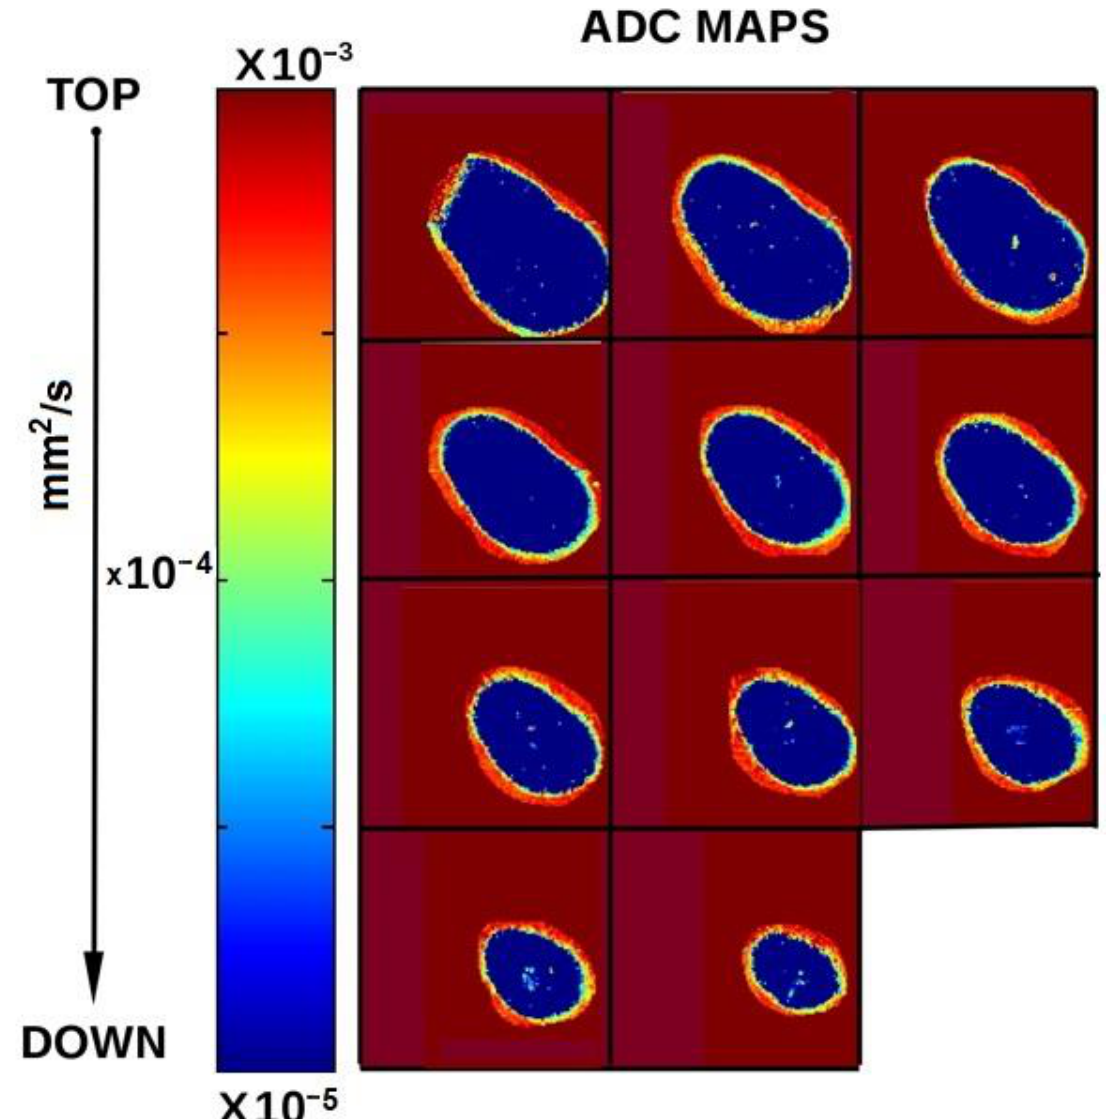
Figure 8. Axial slices of the ADC maps. Pixels with a color different from deep blue indicate the presence of water in pores and spaces, in a larger amount than in normal dentine, representing inadequate root canal filled zones.